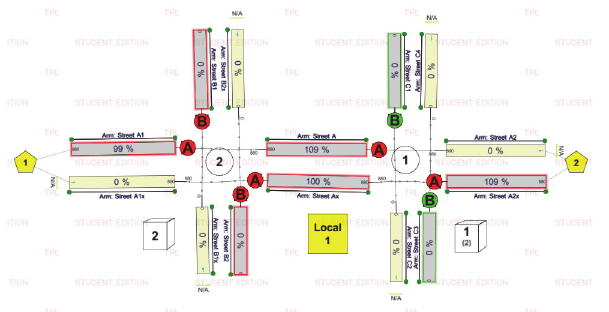
Fig 13. TRANSYST model of the test intersection.